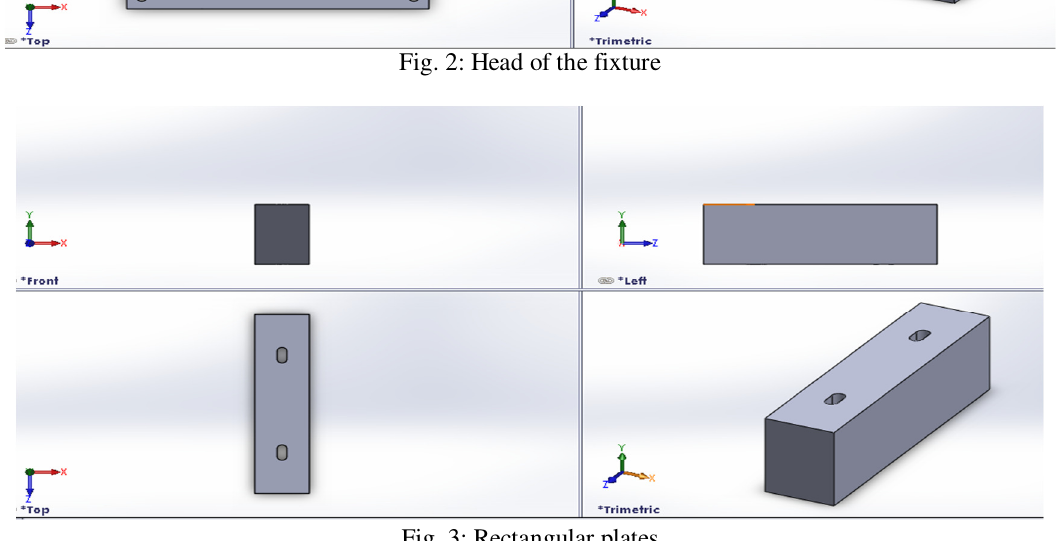
Fig. 3: Rectangular